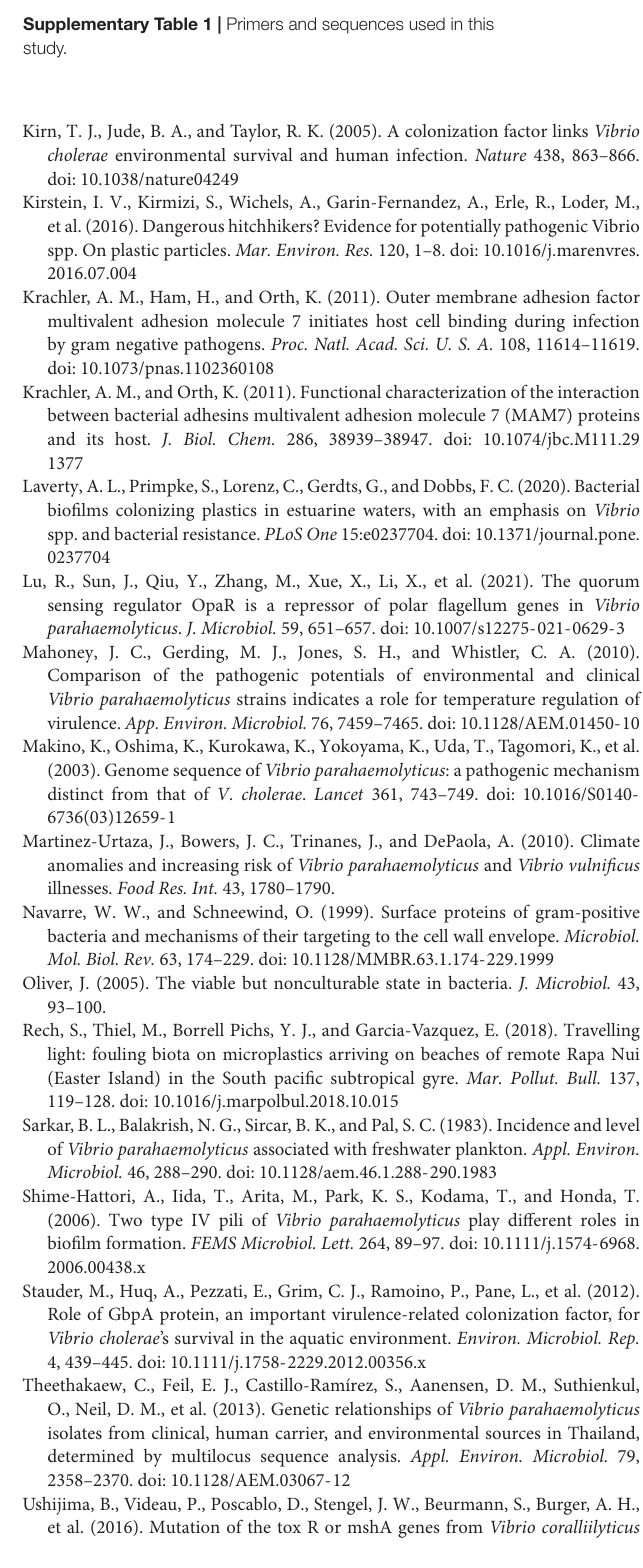
Supplementary Figure 3 | Adhesion and biofilm genes expression at 21 ◦ C in adhering Vp maintained in FSW. Supplementary Figure 4 | TDH expression in free-living (A) or adhering (B) Vp maintained in FSW at 21 ◦ C.